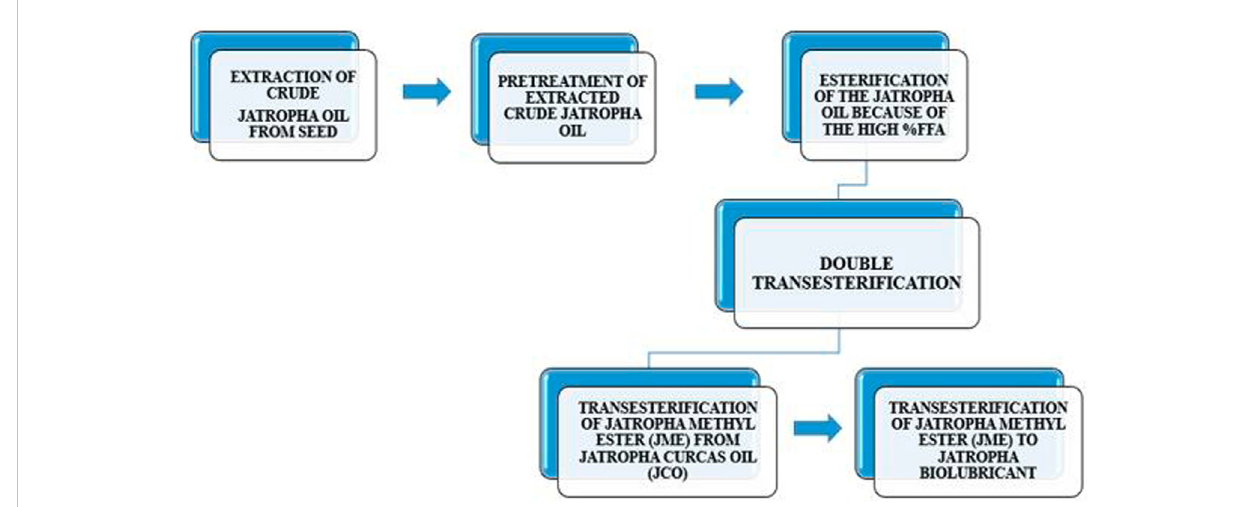
FIGURE 1 Flow diagram of biolubricant production from J. curcas seed